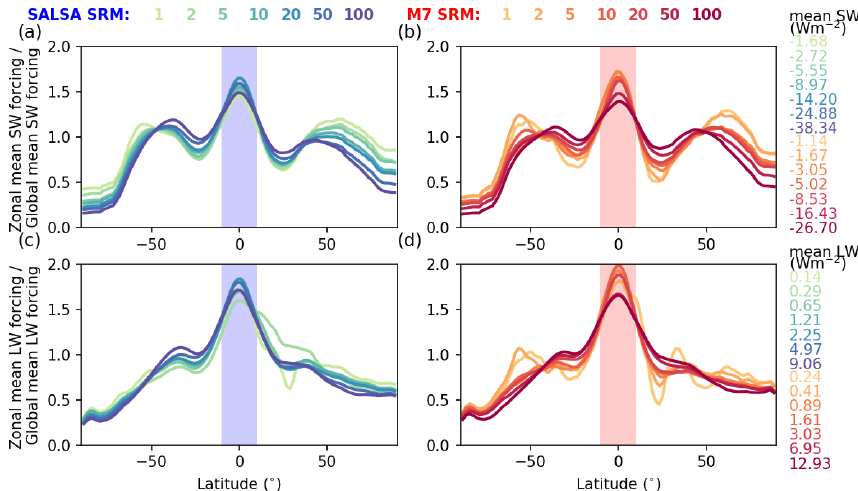
Figure 3. Relative zonal distribution of (a,b) short-wave and (c,d) long-wave clear-sky radiative forcing. The zonal mean forcing in each latitude band is divided by the global mean radiative forcing of the corresponding scenario, which is shown in the legend on the right side of the figure. The blue and red shaded areas show the latitudes where sulfur was injected